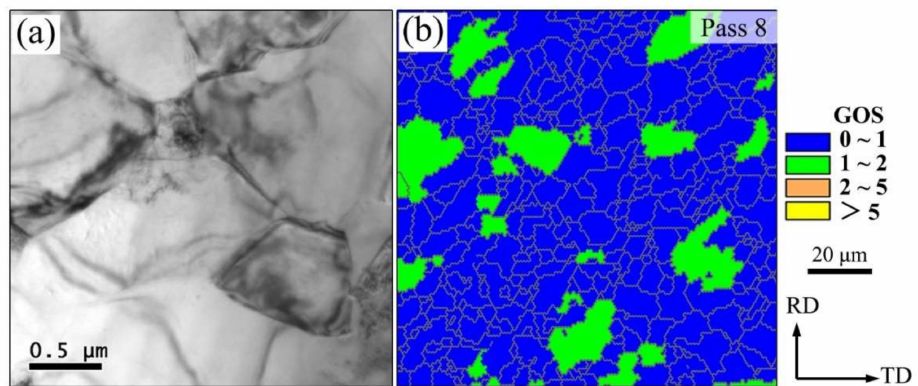
Figure 4. The TEM observations ( a ) and the grain orientation spread (GOS) map for the Pass 8 sheet ( b ). (In GOS map, the GOS value in each grain was determined by calculating the average misorientation between all points within the grain).